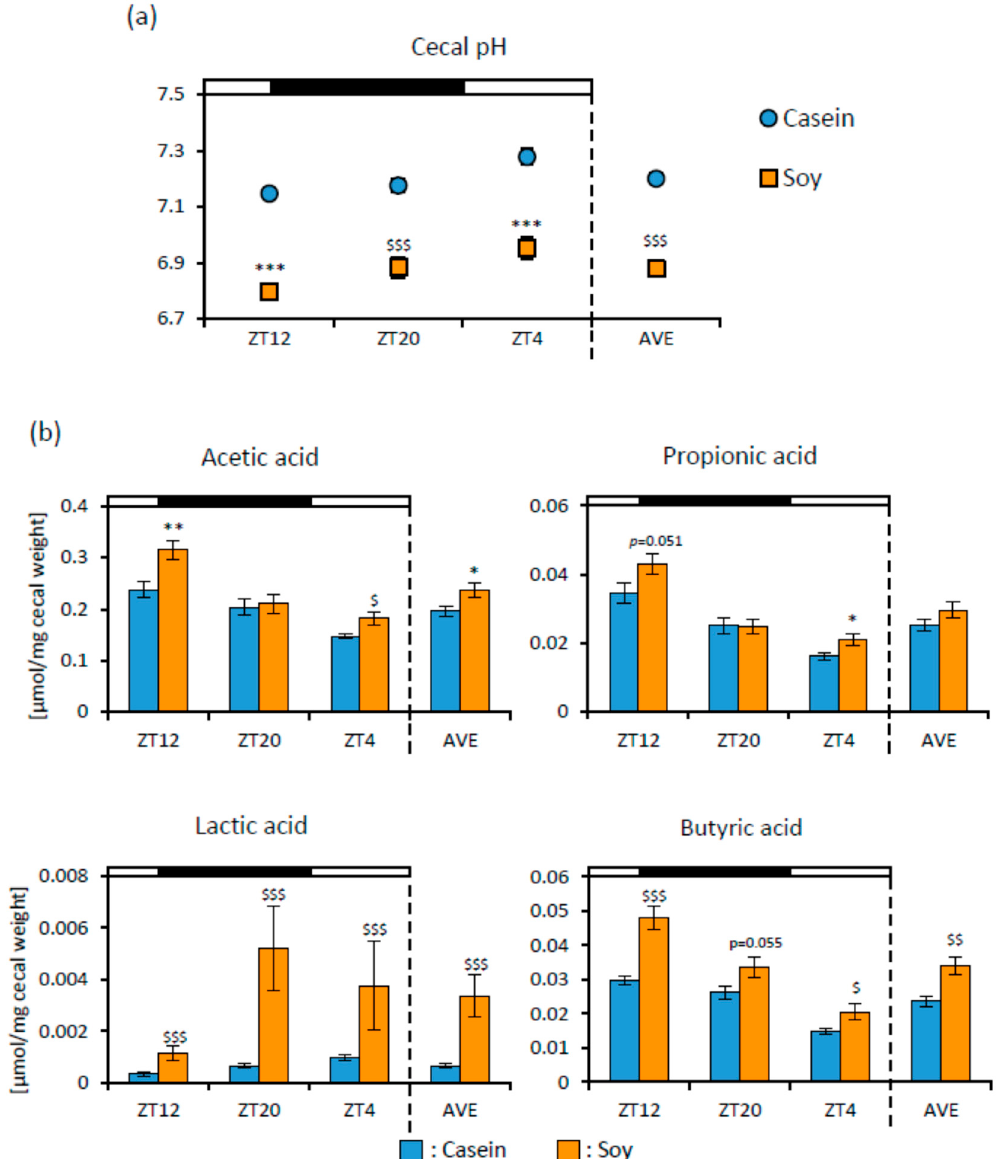
Figure 3. The effect of soy protein intake on cecal pH and SCFA levels. ( a ) Cecal pH levels (ZT12, ZT20, ZT4, and an average of three points) of mice that were fed each diet for 10 days. ( b ) Cecal short-chain fatty acids (SCFA) levels (ZT12, ZT20, ZT4, and an average of three points) of mice that were fed each diet for 10 days. Data are represented as mean ± SEM ( n = 10). * p < 0.05, ** p < 0.01, *** p < 0.001 versus Casein, evaluated using Student’s t -test. $ p < 0.05, $$ p < 0.01, $$$ p < 0.001 versus Casein, evaluated using the Mann-Whitney test.